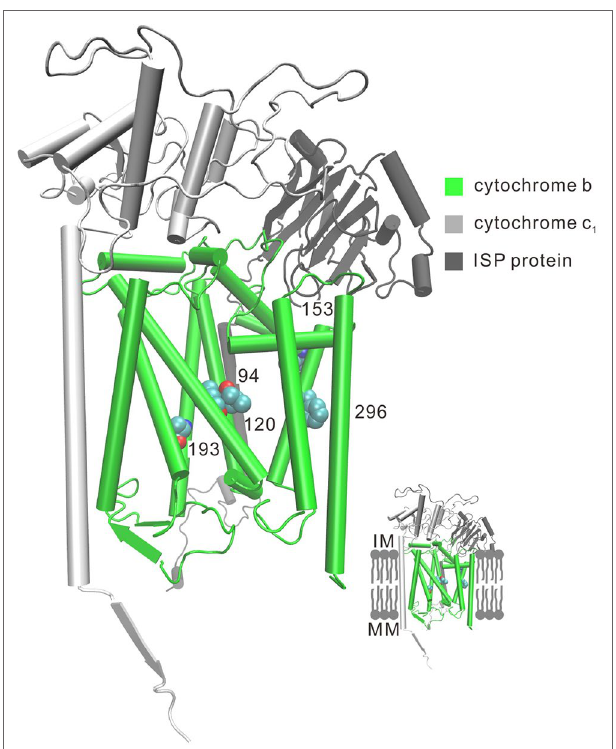
FIGURE 3 | Three-dimensional representation of parallel amino acid sites in deep-sea fishes in cytochrome b . Five parallel amino acid sites I94L, L120F, V153A, T193A, and S296F that occur in the TM subunit in CytB were mapped to the bovine CytB structure (PDB:1PPJ). MM, mitochondria matrix; IM, intermembrane